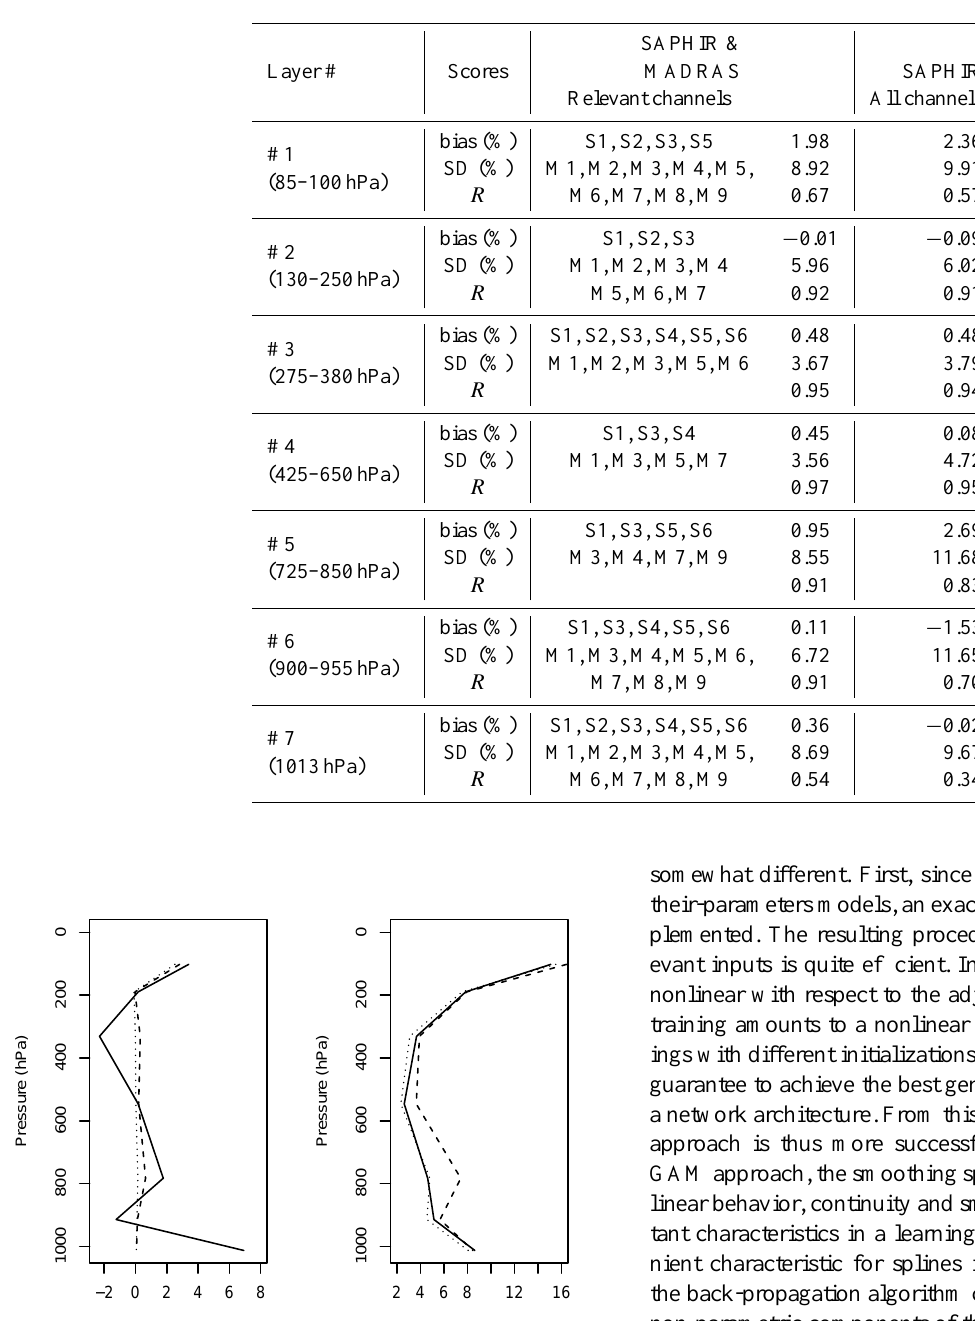
Table 2. Mean bias (in %RH), standard deviation (SD, in %RH) and correlation coefficient ( R ) for the seven layers, and defined between the observed RH and the estimated RH. The estimated RH is obtained using the GAM approach from the two configurations: SAPHIR- MADRAS joint measurements and SAPHIR-only measurements. For the SAPHIR-MADRAS configuration, the relevant channels selected using the GSO procedure are listed using the labels S i and M j indicated in Table 1.